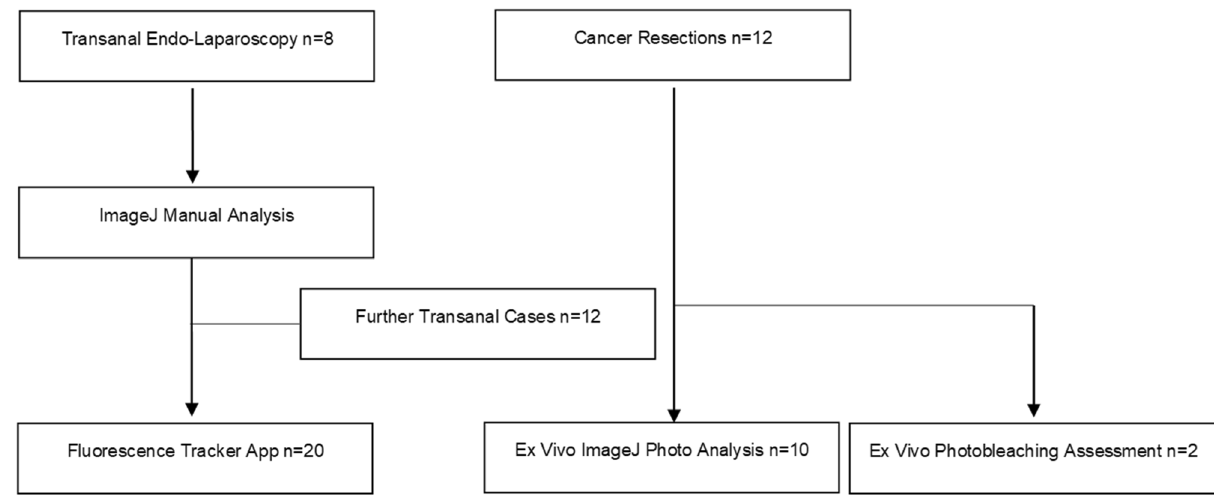
Figure 4. Diagram (Microsoft Word for Microsoft 365) showing cohorts of patients in this study by their methods of fluorescence intensity analysis.